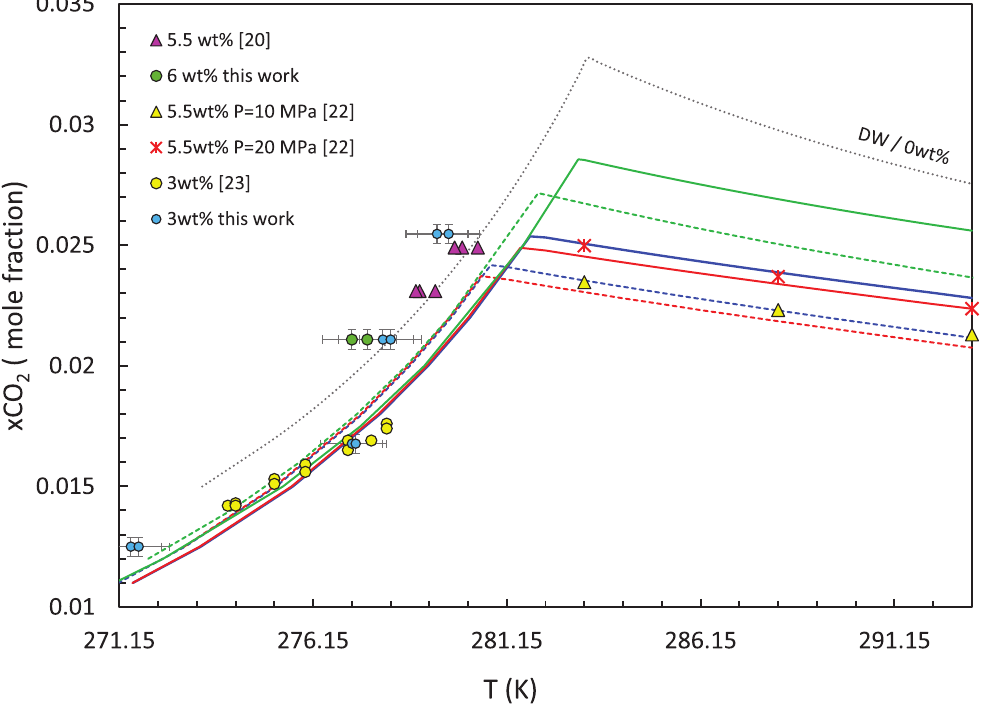
Fig. 9. Comparison of experimental and predicted solubility of CO 2 in NaCl aqueous solutions at H – L w equilibria (grey dashed lines predictions for distilled water at 10 MPa; green lines: predictions for 3 wt% NaCl at 10 (dashed) and 20 MPa; blue lines: predictions for 5.52 wt% NaCl at 10 (dashed), and 20 MPa; red lines: predictions for 6 wt% NaCl at 10 (dashed) and 20